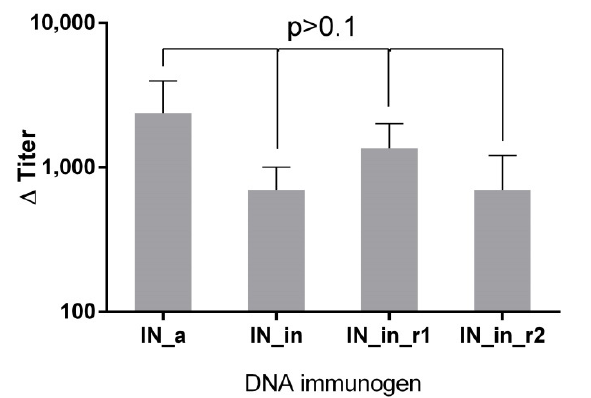
Figure 8. DNA immunization with IN gene variants induces IN-specific antibody response. Endpoint titers of IgG against IN variant used in immunization in the sera of BALB/c mice DNA-immunized with consensus HIV-1 FSU-A integrase (IN_a), consensus IN inactivated by D64V mutation (IN_in) and consensus inactivated integrases carrying mutations conferring resistance to raltegravir (IN_in_r1, IN_in_r2). Data represent the mean of two independent ELISA runs, each done in duplicate. Values on Y-axis (Titer bar) represent the mean end-point antibody titers of individual mice DNA immunized with IN variants with subtracted mean end-point antibody titer of the vector group, +SD. No statistically significant differences were detected between endpoint titers of sera of mice immunized with different IN genes variants, p > 0.1 (Mann–Whitney test with Holm multiple comparisons correction).